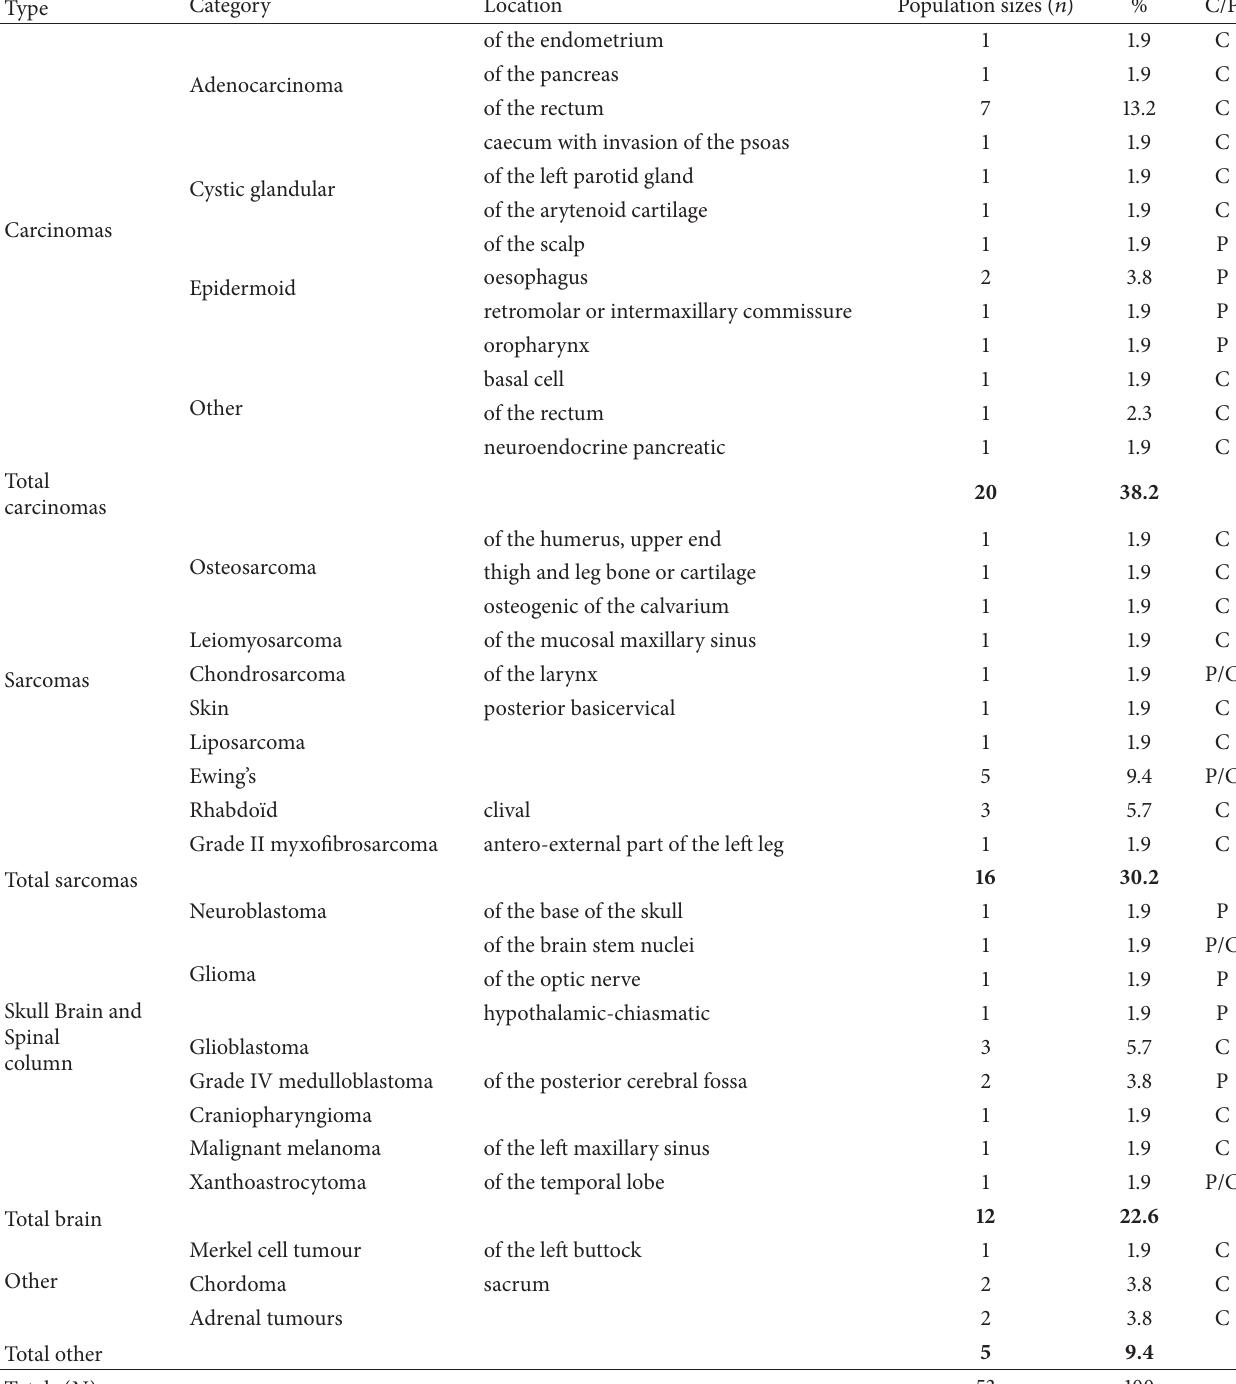
Table 4: Results, EpiHadron study: list of cases identified by anatomical